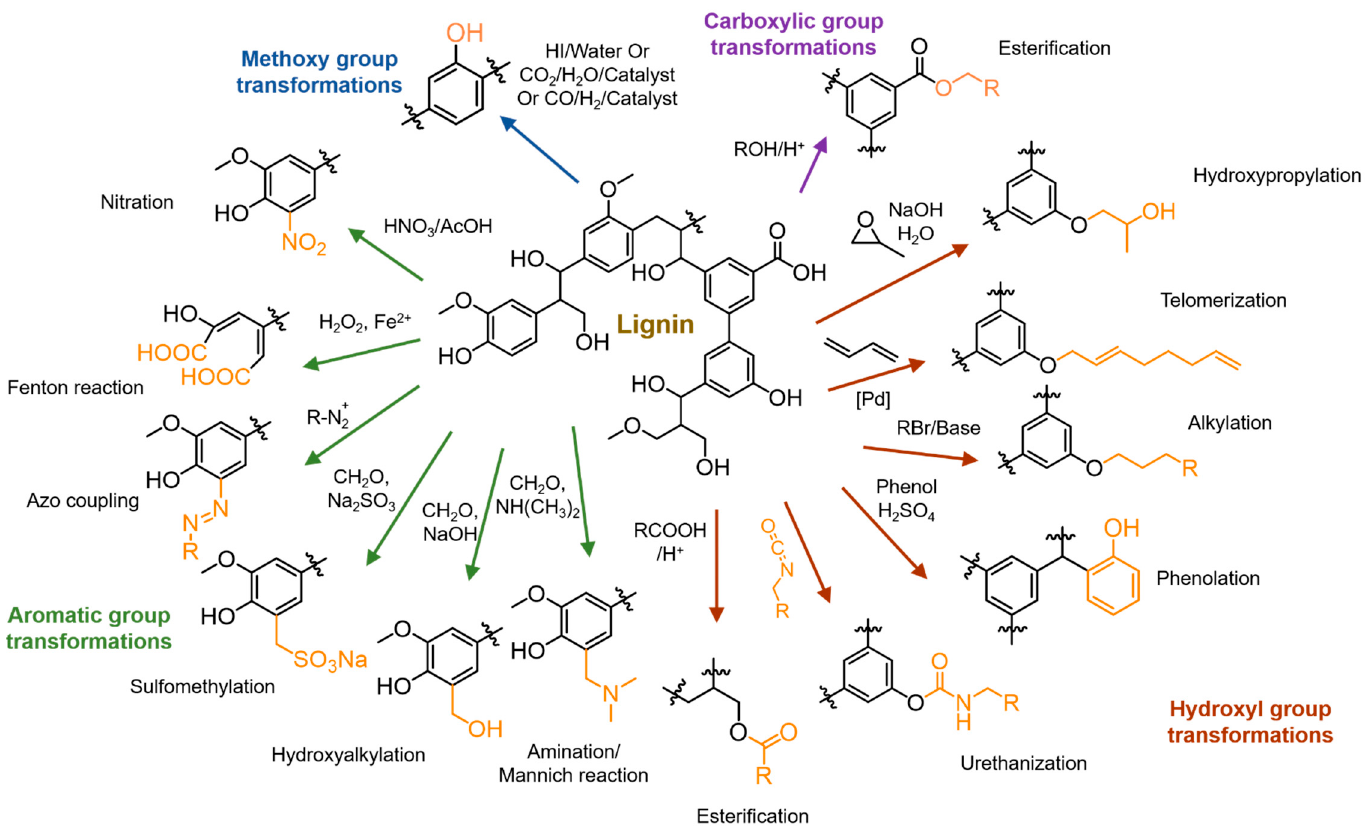
Figure 5. A summary of chemical trasnformations to diversify chemical functionality on lignin. 3